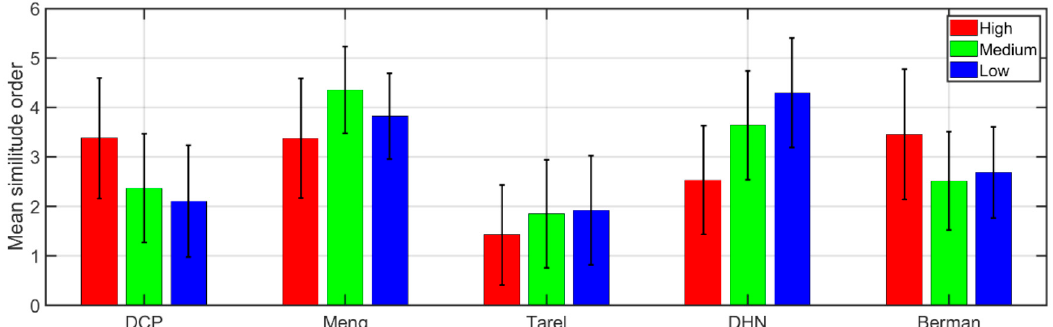
Figure 8. Average ranking (with standard deviation shown as error bars) of each algorithm across three wavelengths (530 nm, 620 nm and 710 nm) for the low and medium haze conditions, and two wavelengths (620 nm and 710 nm) for the high haze condition.